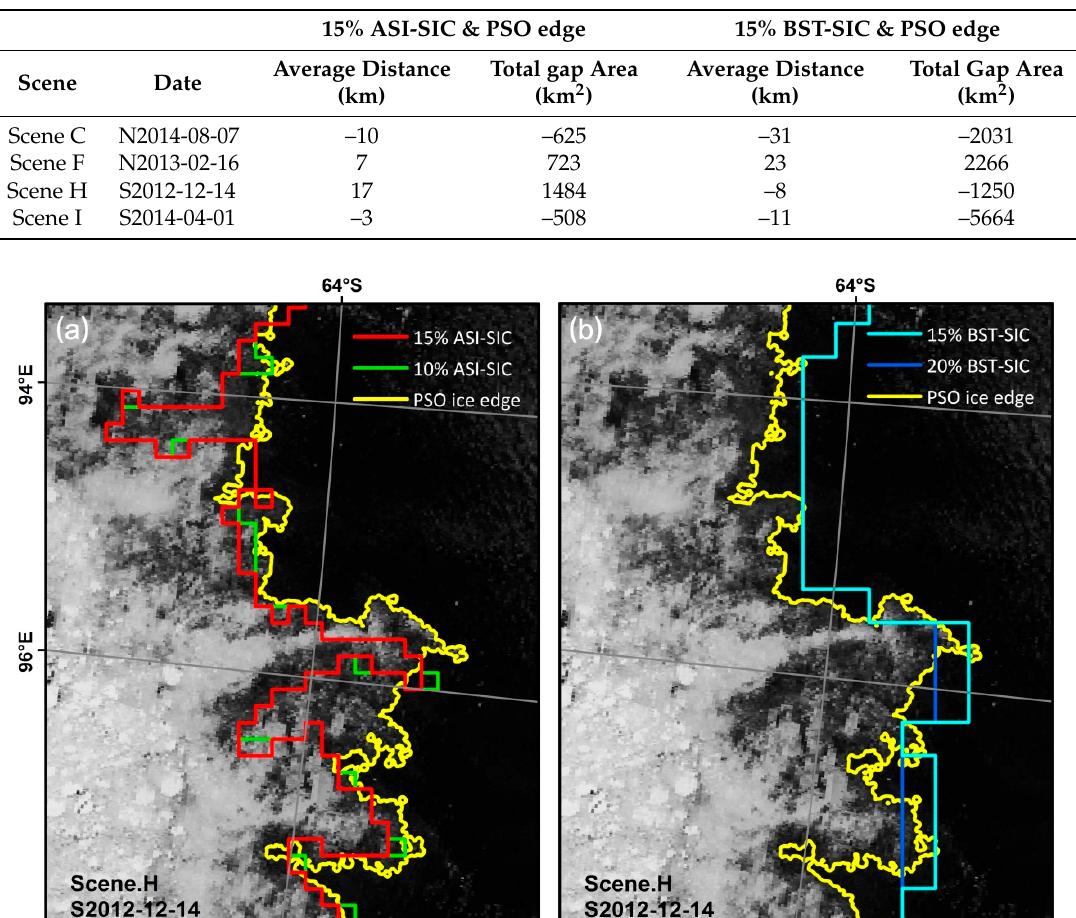
Table 3. Differences among three ice edges statistics by average distances and total gap areas. Minus means the line of 15% ASI-SIC/BST-SIC is on the outside of the PSO edge.